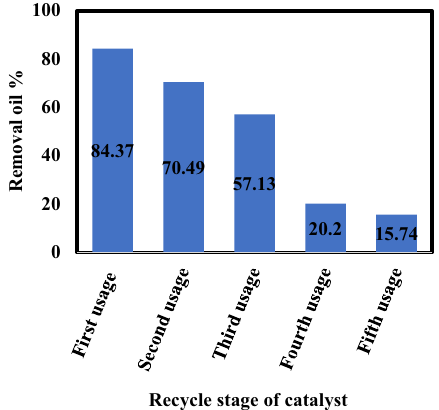
Figure 9. Influence of photo-catalyst recycle on oil removal